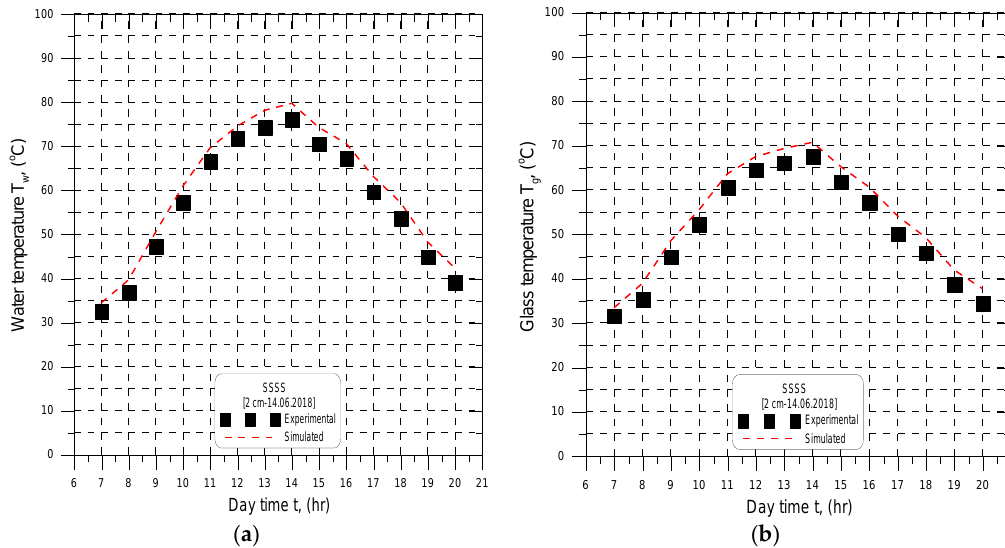
Figure 11. Simulated and experimental results comparison for the water and glass cover temperatures of the tested solar still at water depth of 2 cm. ( a ) Comparison of water temperatures ( b ) Comparison of glass cover temperatures.